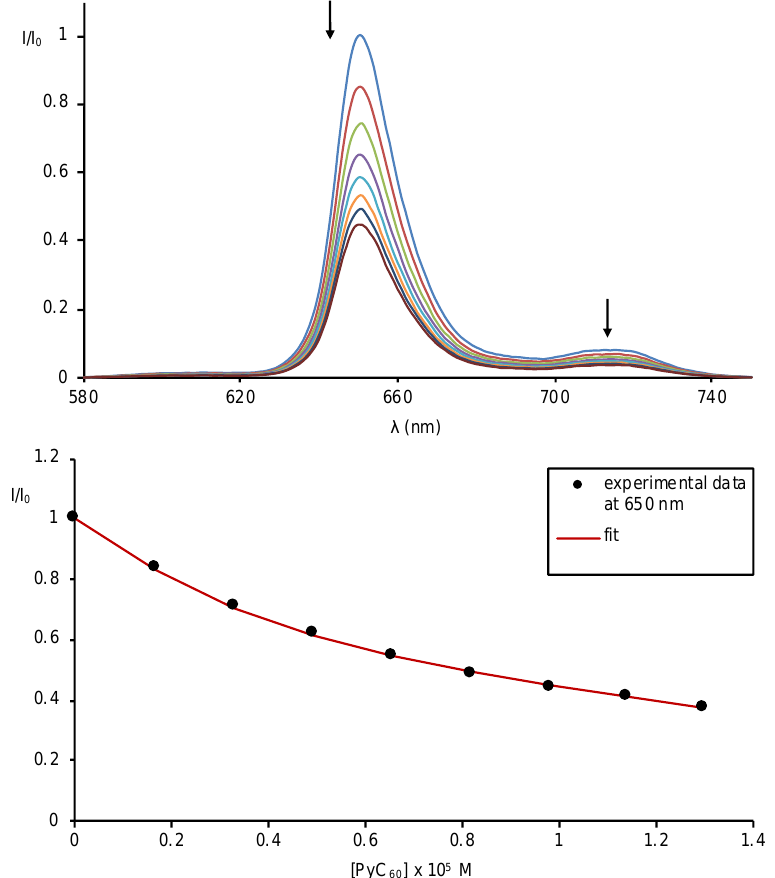
Figure 6. Fluorescence spectra ( λ exc = 428 nm) of 6 (1.0 × 10 − 7 M) upon addition of PyC 60 (0–113 equiv.) in toluene at 23 ◦ C ( upper part ) and experimental data at 650 nm fitted to a non-linear 1:1 binding model ( lower part ).